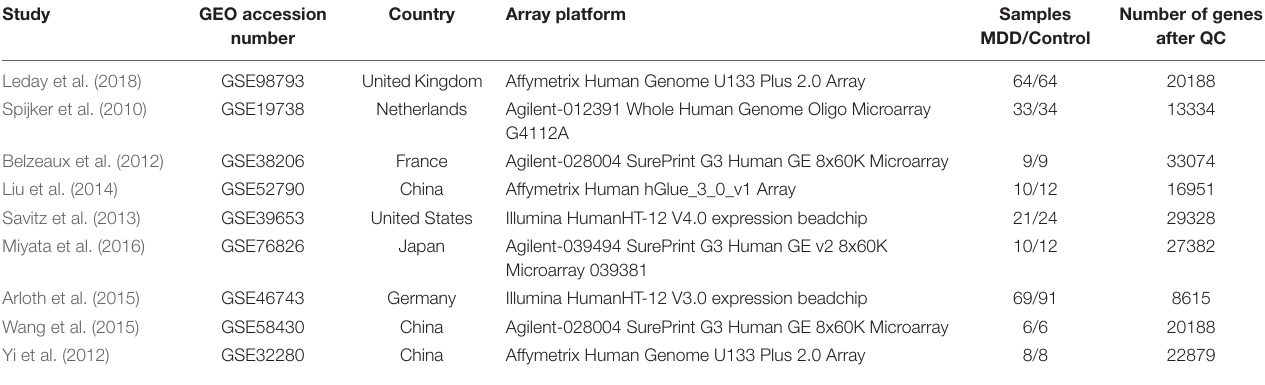
TABLE 1 | Basic information of collected microarray